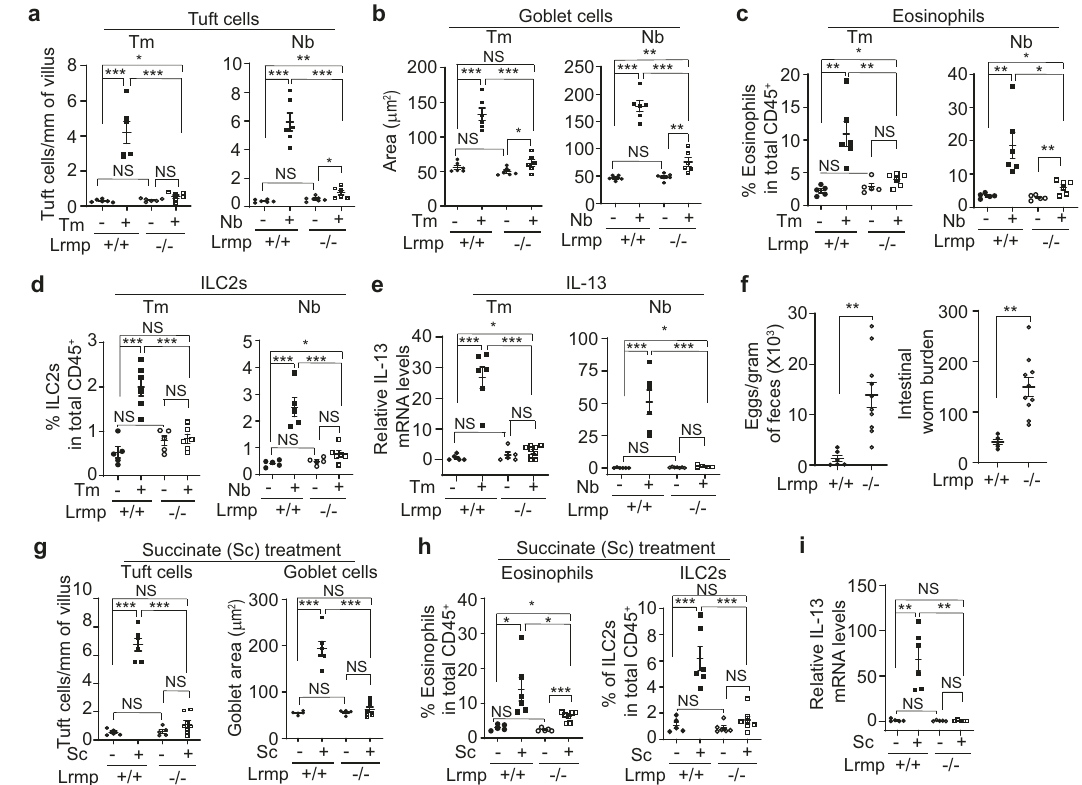
Fig. 5 The intestinal type 2 immune response induced by parasitic infections and succinate is impaired in Lrmp − / − mice. a – f WT and Lrmp − / − mice were infected with Tm or Nb and examined at 21 d.p.i. (for Tm ) and 5 or 7 d.p.i. (for Nb ), respectively. a and b Quanti fi cations of tuft ( a ) and goblet ( b ) cells in the small intestine of mice by IHC staining of Dclk1 and Alcian blue staining, respectively. c and d Quanti fi cations of eosinophils ( c ) and ILC2s ( d ) in the LP by fl ow cytometric analysis. e Relative IL-13 mRNA levels in the small intestine determined by quantitative real-time PCR assays. f Egg counts in feces (left) and worm burden (right) in the intestine in Nb -infected mice. g – i The impaired type 2 immune response induced by succinate (150 mM for 7 days) in Lmrp − / − mice. g Quanti fi cations of tuft and goblet cells in the small intestine. h Quanti fi cations of eosinophils and ILC-2s in the LP. i Relative IL-13 mRNA levels in the small intestine. Data are presented as mean ± SEM. Each dot represents an individual mouse. n = 5 – 8/group. * p < 0.05; ** p < 0.01; *** p < 0.001; NS: non-signi fi cant, two-tailed Student ’ s t